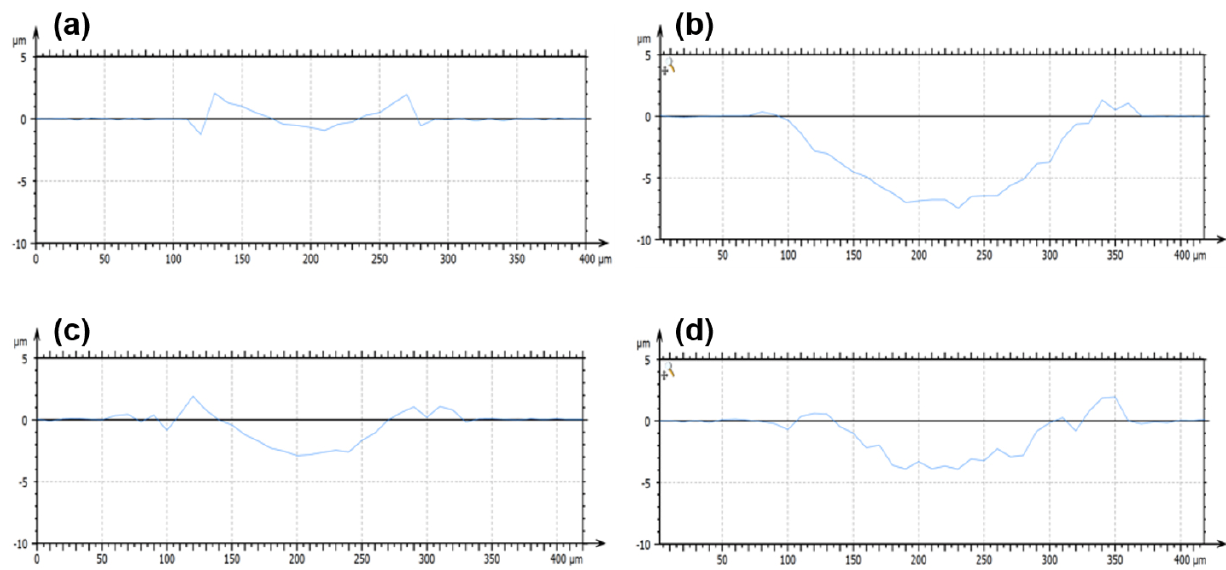
Fig. 11 2D profiles of wear tracks on the steel disks after lubricated with (a) MO at room temperature, (b) MO at 100 ºC, (c) 1 wt% DCi+MO at room temperature, and (d) 1 wt% DCi+MO at 100 ºC.